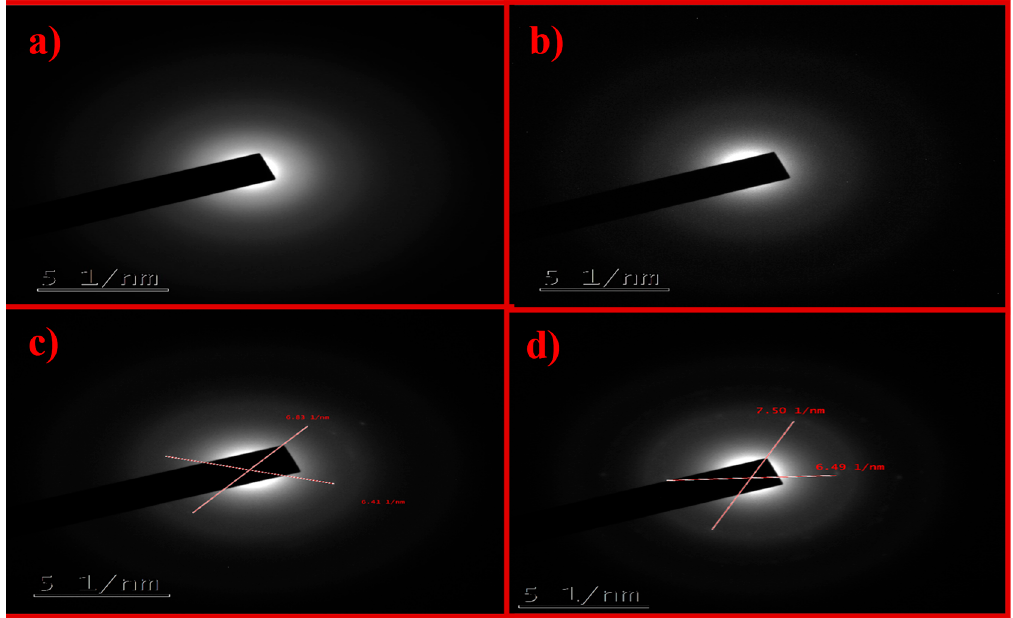
Figure 5. Selected area electron diffraction (SAED) patterns of K–GO ( a ), N–GO ( b ), F–GO ( c ), and C–GO ( d ).